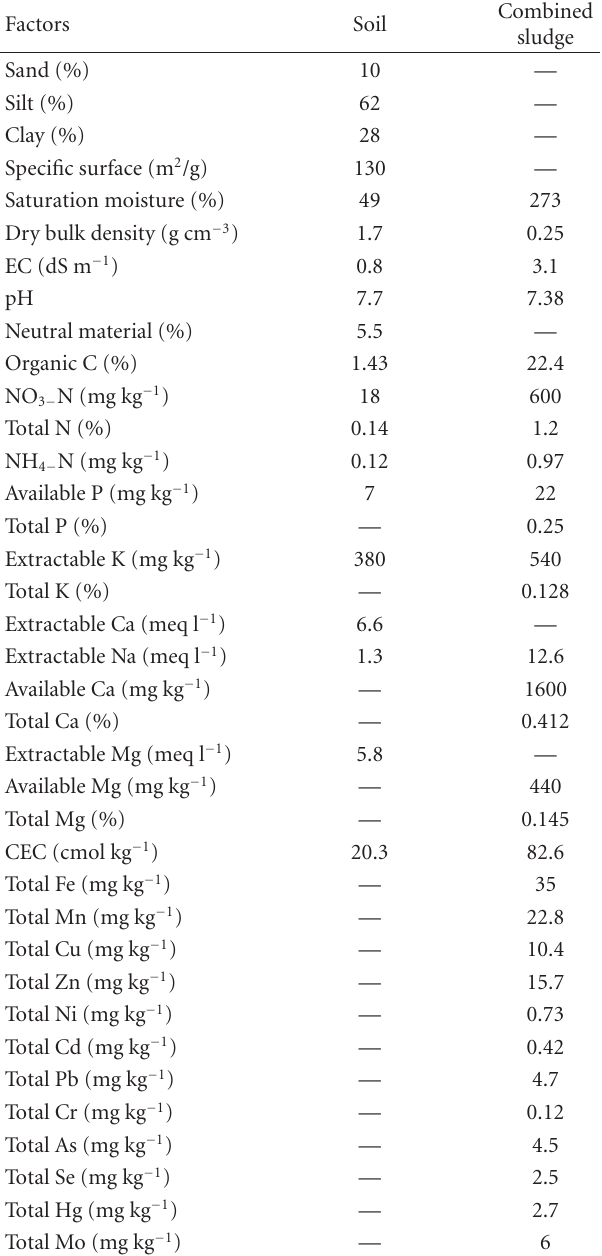
100 t/ha were, respectively, twice as much. C/N ratio was 18.6 Table 1: Chemical and physical analysis of the soil and combined sludge. with negligible or no potential harm for plants through N immobilization. In terms of potentially toxic elements [19], Combined application rates were well below maximum permissible Soil sludge limits for Cu, Zn, Ni, Cd, Pb, Cr, As, Se, Hg and Mo. pH, EC, SP, and dry bulk density are also presented in Table 1. The sludges obtained from Mazandaran wood and paper mill (Iran). In this mill, mechanical and chemical methods (both Kraft and sulfite processes) are used for pulping or wood fiber breakdown. The paper-mill sludge used for this research is a mixture of primary and secondary sludges (combined